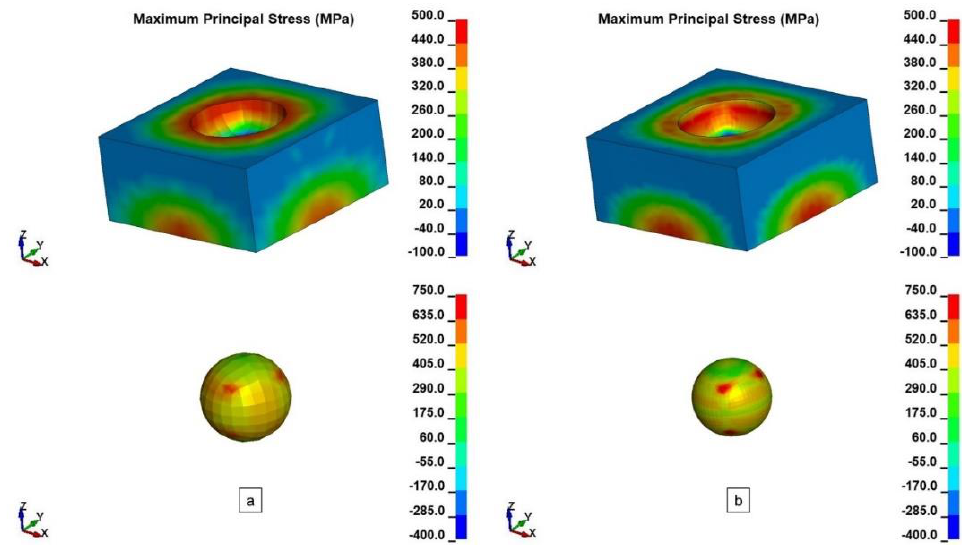
Figure 4. Maximum principal stress contours in the middle section of the Ti cube and SiC sphere for ( a ) 10 nm and ( b ) 5 nm average element size. The units are in MPa.